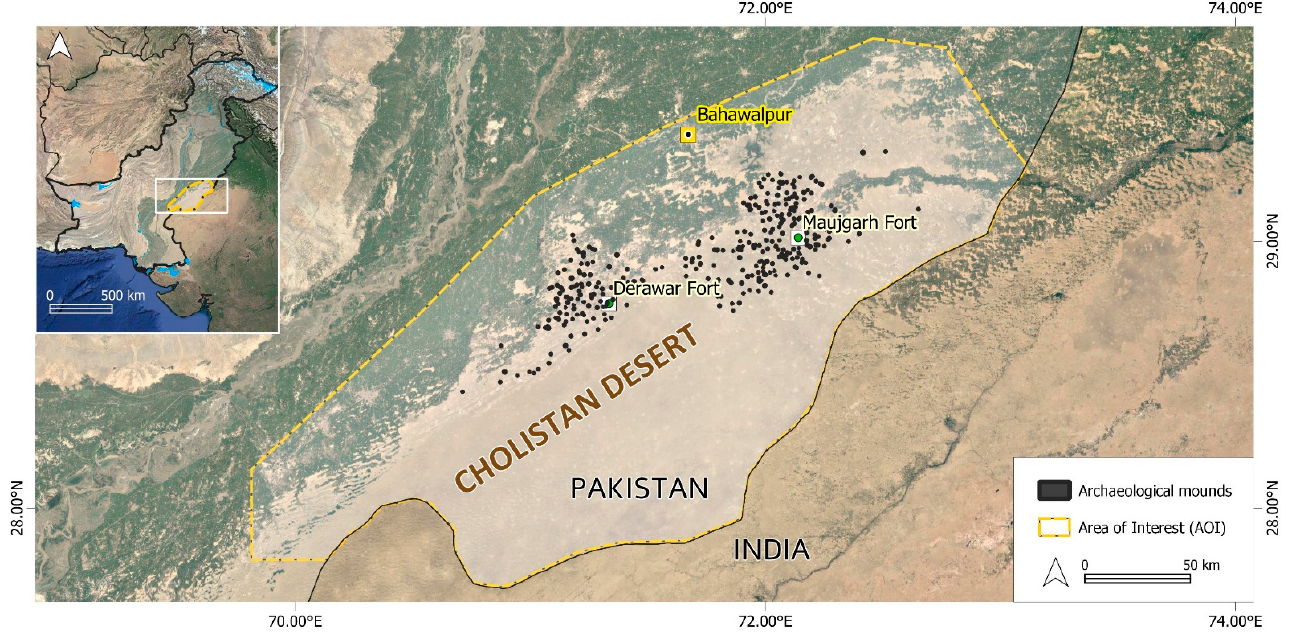
Figure 1. Map location of the Cholistan Desert in eastern Pakistan, showing the extent of the archaeological mounds (after [7]). Base map: Google Imagery.